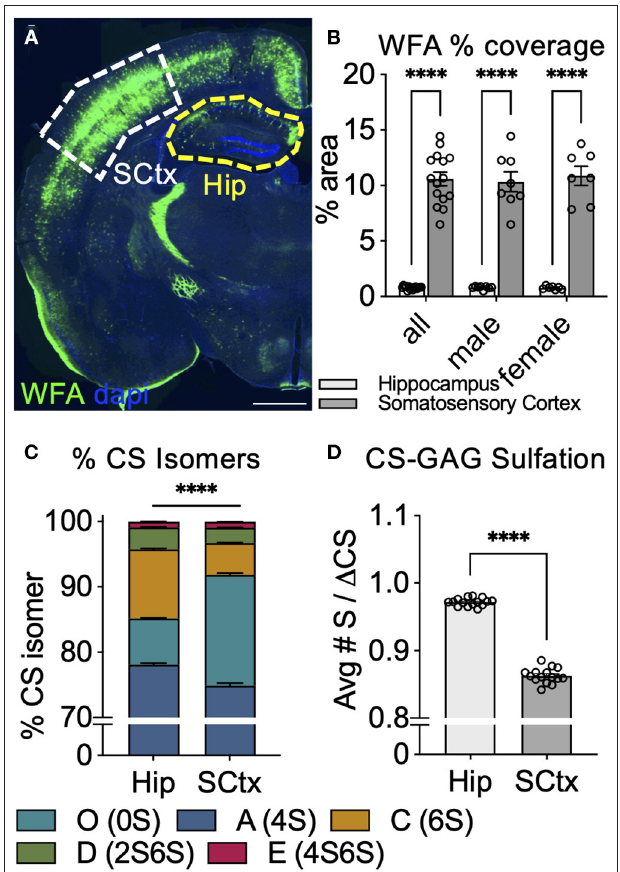
FIGURE 6 | Abundance of WFA + PNNs associates with changes in CS-GAG sulfation patterns across brain regions. (A,B) WFA labeling of PNNs in adult mouse brain shows increased WFA + PNNs in the somatosensory cortex (SCtx, white ) and decreased WFA + PNNs in the adjacent hippocampus (Hip, yellow ) ( n = 8 male, n = 7 female mice) Scale: 1mm. Interregional differences in WFA + PNN-labeling significantly associate with (C) decreased abundance of the non-sulfated CS-O (0S) isomer and (D) hypersulfation of CS-GAGs. **** p < 0.0001. CS-GAG, chondroitin sulfate-glycosaminoglycan; WFA, Wisteria floribunda agglutinin; SCtx, somatosensory cortex; Hip, hippocampus.